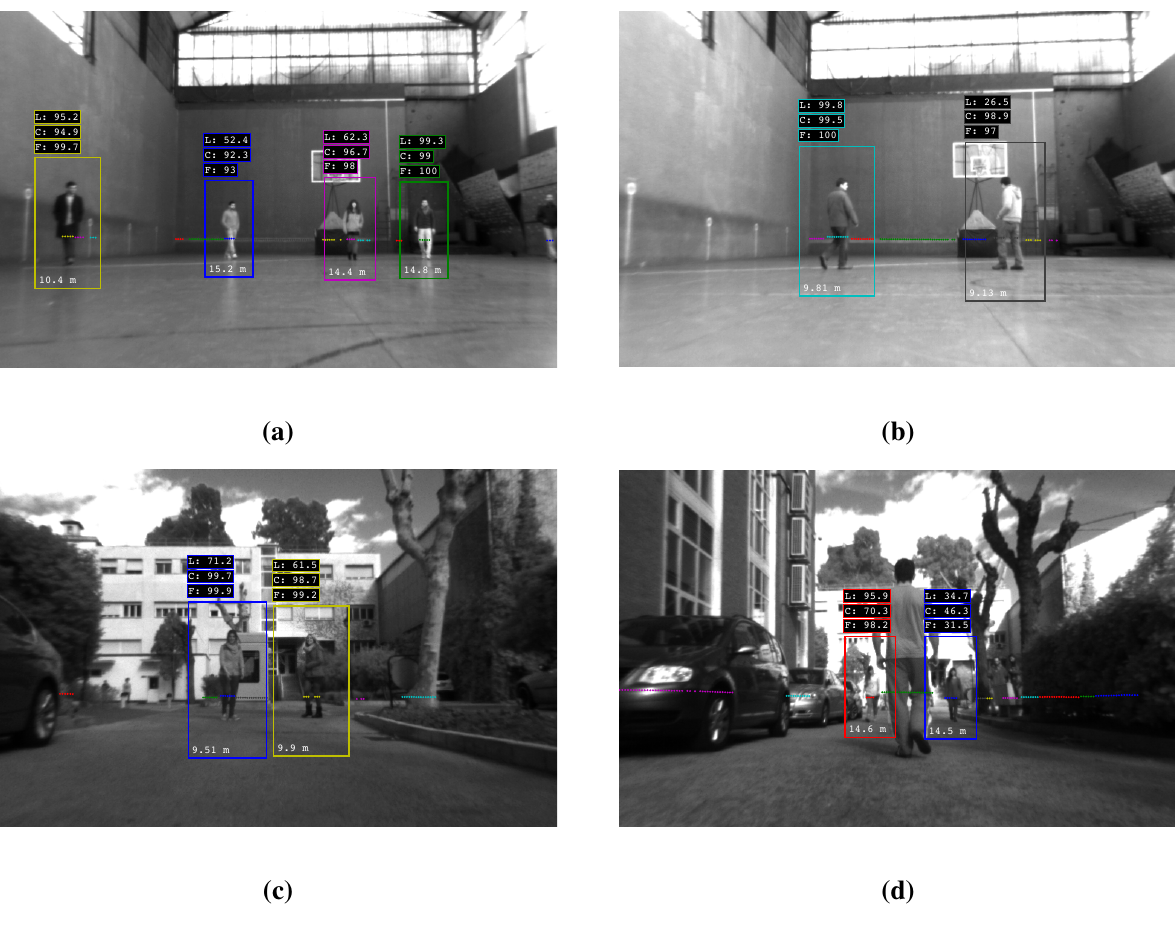
Figure 10. Detector images from the gymnasium (a) , (b) and outdoor experiments (c) , (d) . The boxes above each cluster give the probability of the laser and image detection modules and the mean fused probability. Cluster distance is shown at the bottom of the enclosing rectangle. (a) Typical scenario with multiple people, movement in various directions and occlusions. (b) The laser module does not detect the right person correctly. Due to correct camera classification, the person is eventually detected after fusion. (c) Outdoors, the laser detector performance is considerably lower. (d) The right person (blue rectangle) is misclassified from both sensor modules. The person in the middle is too close to the camera; in this case, the cluster is evaluated by the laser classifier only. Persons hidden by the bench on the right are not detected by the